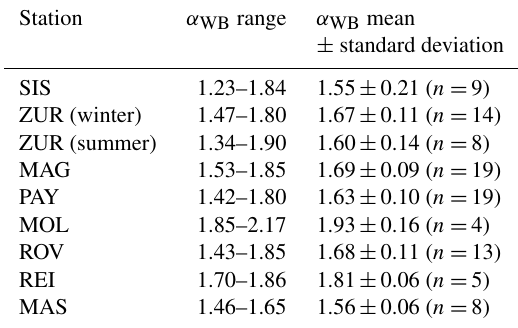
Table 2. Ranges and averages of α WB values resulting in a ra- tio of 1 between EBC TR / EBC (at 950nm) and EC F / EC for all stations calculated with α TR of 0.9, b abs , 470 , b abs , 950 , and MAC TR / MAC WB =